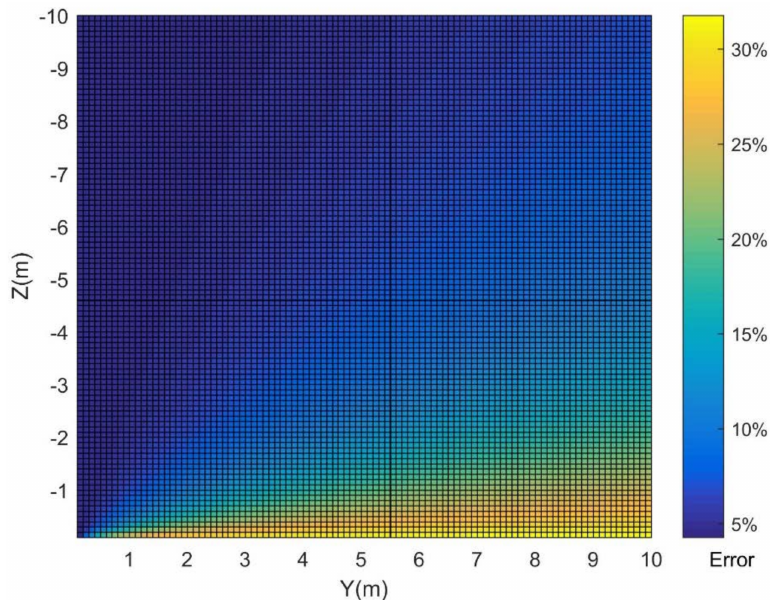
Figure 11. The target position corresponding to the sonar position impacts the positioning error, which is the error distribution when the target moves at a specified